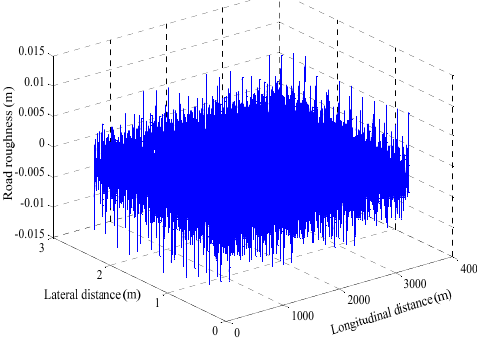
Figure 2. 3-D road roughness for Level ISO -A (at a velocity of 80 km/h).